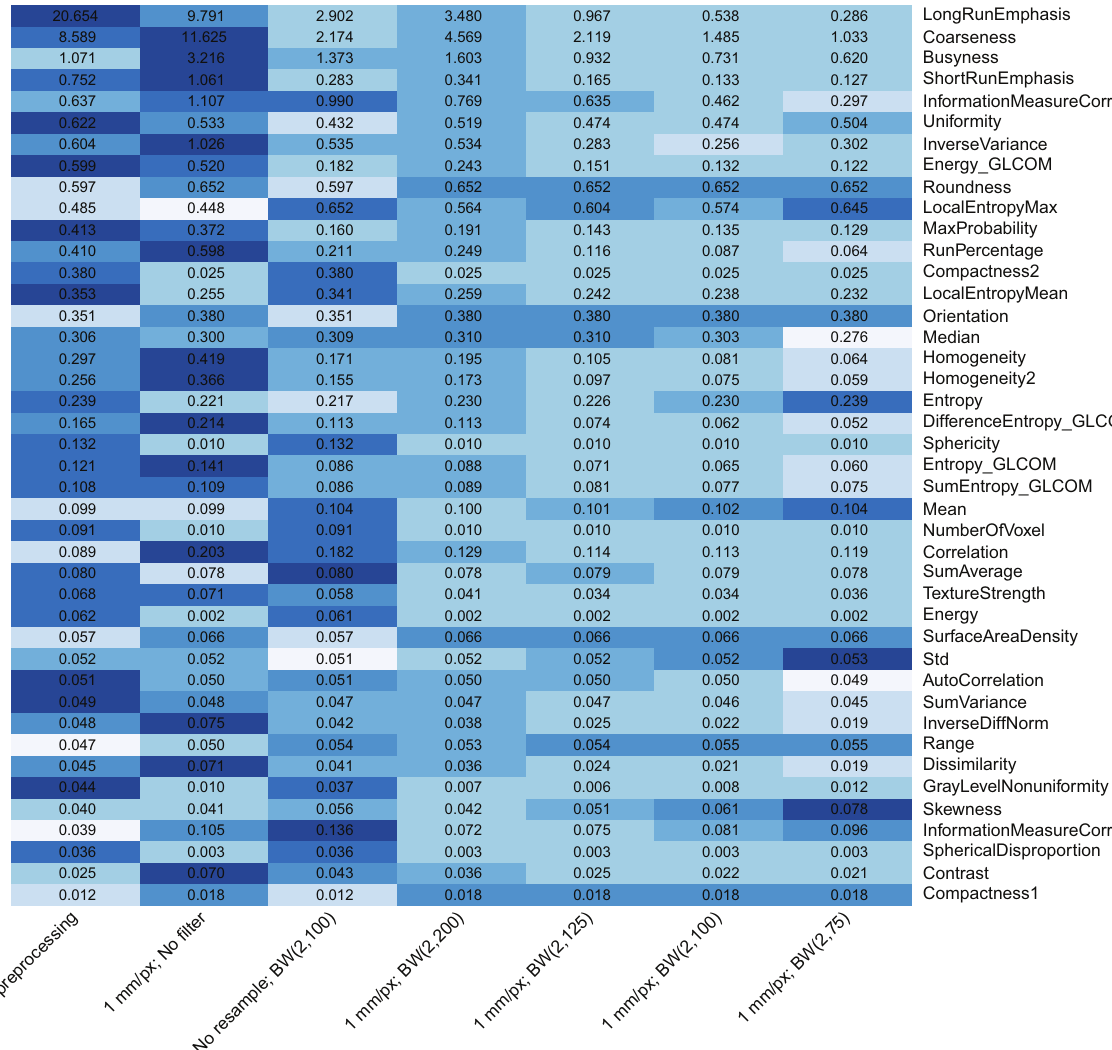
Fig 6. Heat map comparing the scaled variability for the 7 pixel size correction levels for the sycamorewood cartridge of the CCR phantom. The features were calculatedfor the phantomfor 17 scans. The color is rescaled on a row-by-row basis, and darker colors indicatemore variability. The values in the cell are the scaled variabilityvalues. BW indicates Butterworth; px,